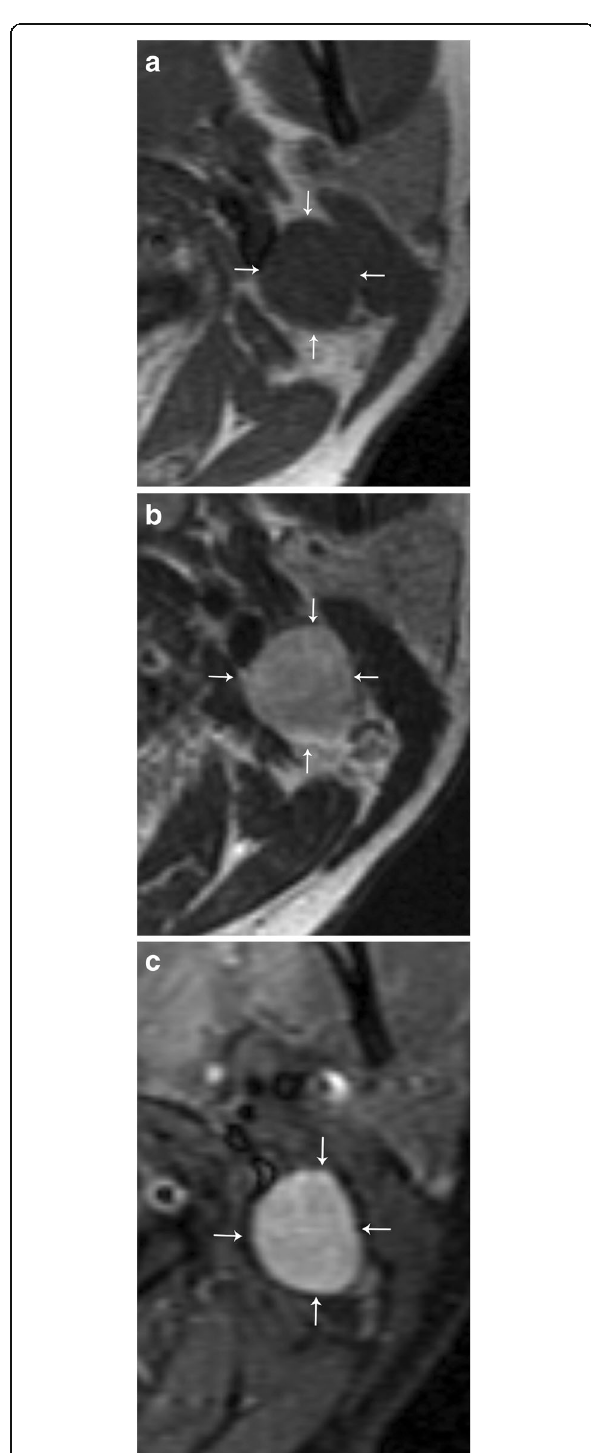
Fig. 8 Schwannoma. a Axial T1 weighted MR image shows a well- circumscribed mass (arrows), which is low in signal. b T2-weighted MR image show that this mass is T2 hyperintense (arrows). c Post- contrast T1-weighted image shows avid and uniform enhancement of the mass